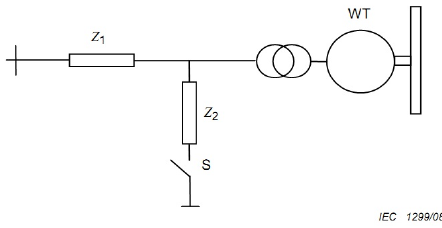
Figure 6. Impedance voltage sag generator [30].